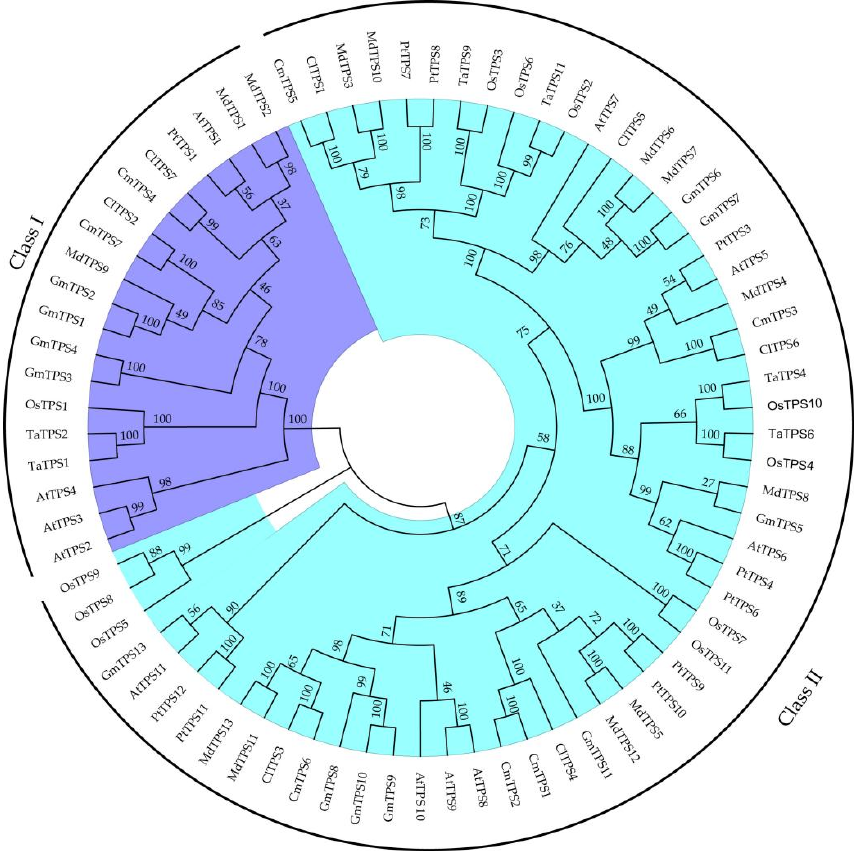
Figure 2 . Phylogenetic relationship of TPS proteins among watermelon and other seven species. All TPS proteins were divided into two subgroups, represented by two colors. The green color represents Class I protein, and the blue color represents Class II protein. The phylogenetic tree was constructed by MEGA7 software with 1000 bootstrap replicates, following the neighbor-joining method.